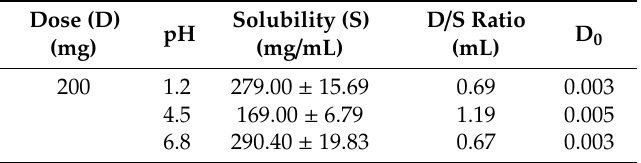
Table 3. Solubility results of 200 mg NF in three di ff erent pH media at 37 ◦ C. Results of the three replicates are presented as the mean ± SD.